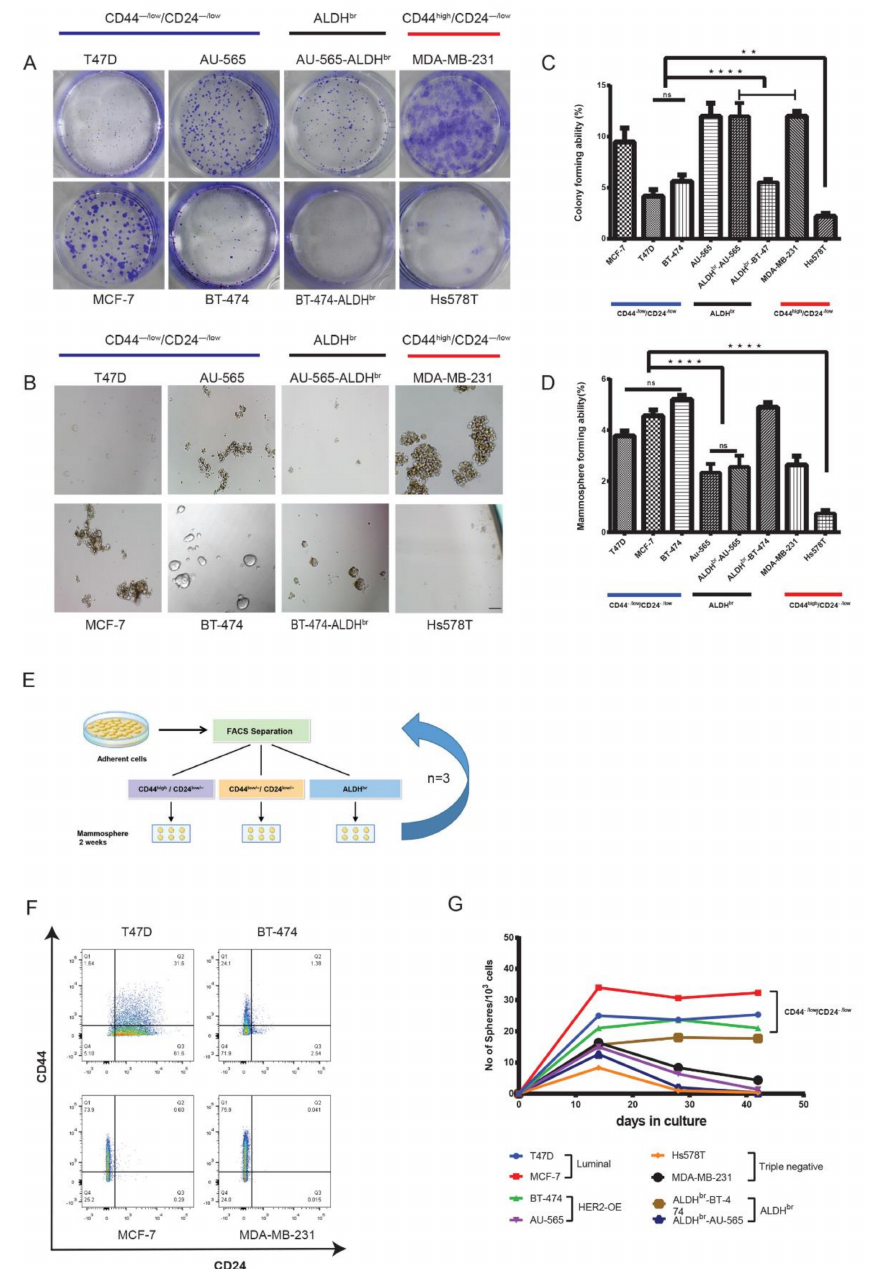
Figure 2. Luminal CD44 − / low / CD24 − / low cells propagate as colonies and form long-term viable spheres. ( A , C ) Representative images and comparison of clonogenic assay and mammosphere assay ( B , D ) of the flow sorted CD44 − / low / CD24 − / low , CD44 high / CD24 − / low and ALDH br subpopulations from breast cancer cell lines. Spheres were counted after 7 days in culture (Supplementary Figure S2). ( E ) Schematic representation of long-term mammosphere assay. FACS-separated populations were seeded at a density of 2 × 10 4 cells / mL in ultra-low-attachment plates and maintained as spheres. The whole procedure was repeated every 14 days, until 42 days (three generations). ( F ) FACS analysis of CD44 − / low / CD24 − / low , ALDH br and CD44 high / CD24 − / low mammospheres after three generations (42 days) shows a decrease in CD44 expression in mammospheres of CD44 high / CD24 − / low origin from the MDA-MB-231 cell line. AU-565 and Hs578T cell lines could not form viable mammospheres after 7–12 days in culture. ( G ) Graph showing the number of viable mammospheres before each FACS separation. Spheres were counted under a microscope at 10 × magnification. Data represent the mean ± SD of three independent experiments; ** p < 0.01 and **** p < 0. 0001. Scale bar = 200 µ